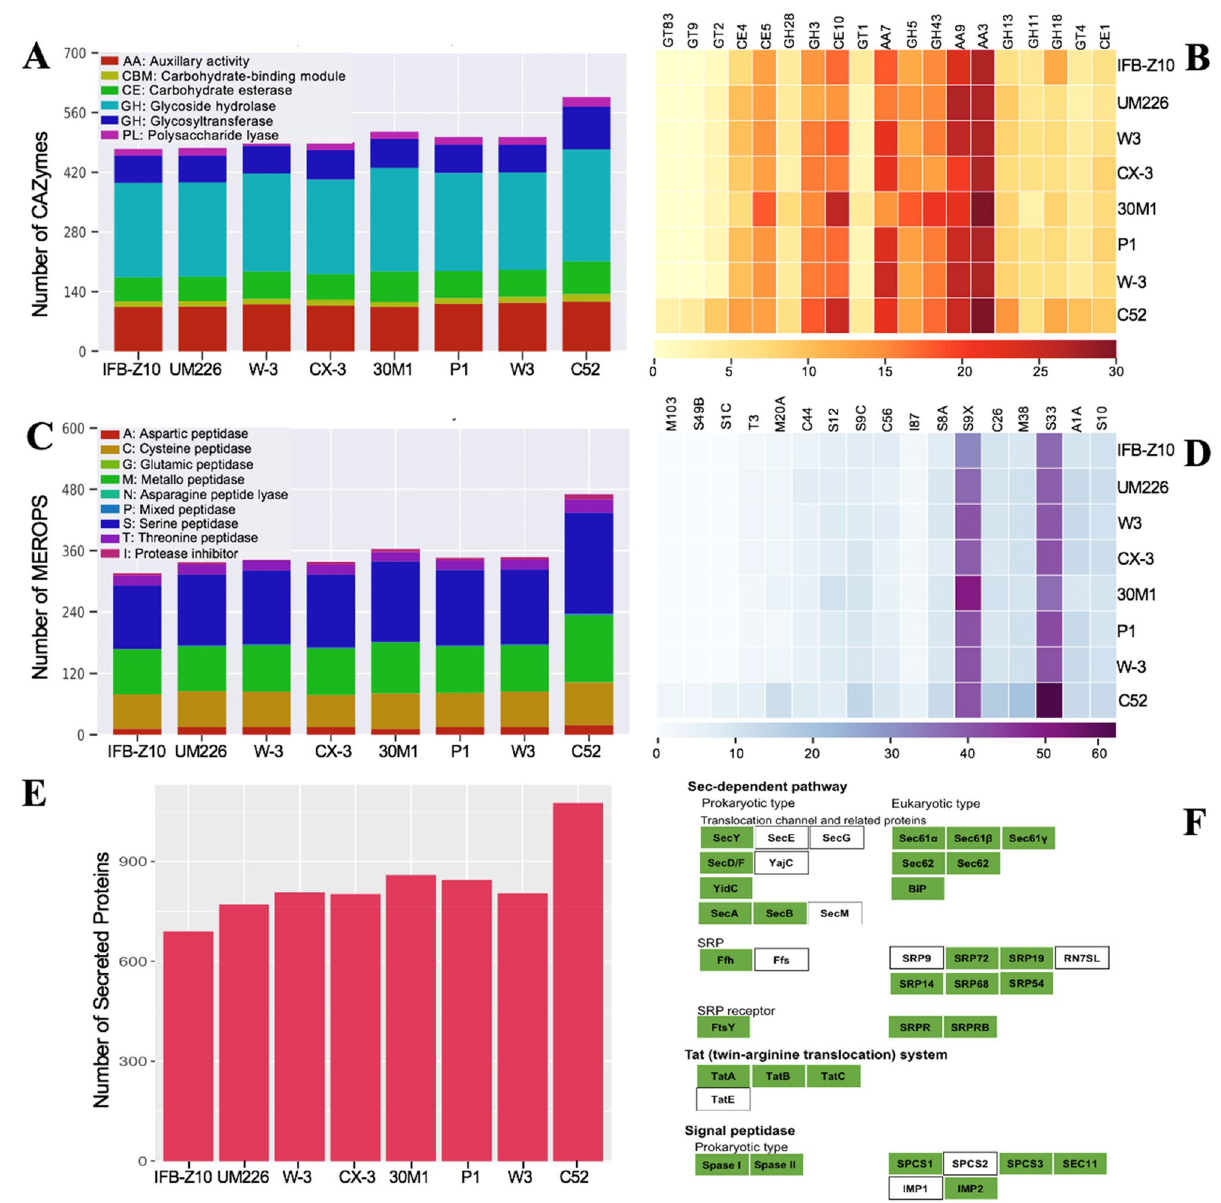
Figure 3. The comparative analysis of CAZymes and proteases from C. eragrostidis C52 and 7 Curvularia genomes . CAZymes distribution ( A ) and heatmap showing the most abundant CAZyme families ( B ) in the proteomes of Curvularia species. Distribution of protease families ( C ) and heatmap showing the most abundant protease families found in Curvularia genomes ( D ). Secreted proteins ( E ) and protein export predicted by KEGG 19 ( F ) in C. eragrostidis C52. C52, C. eragrostidis C52; W-3, C. geniculata W_3; 30M1, C. kusanoi 30M1; CX-3, C. lunata CX-3; W3, C. lunata W3; UM226, C. papendorfii UM 226; P1, C. geniculata P1; IFB-Z10, Curvularia sp.